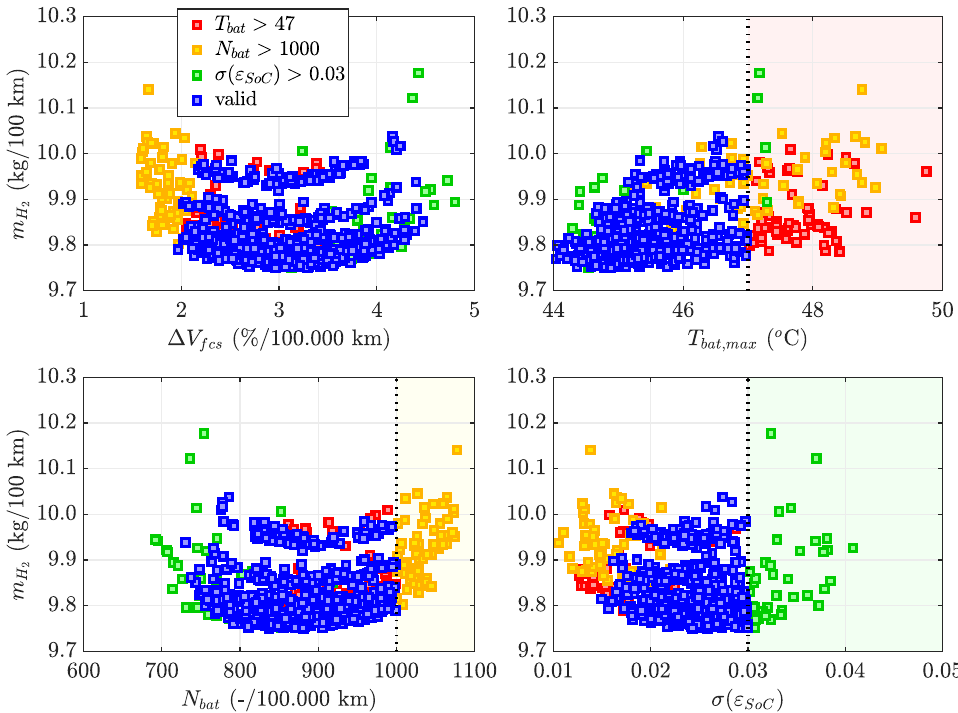
Figure 8. Measurements collected during the optimal calibration of the EMS